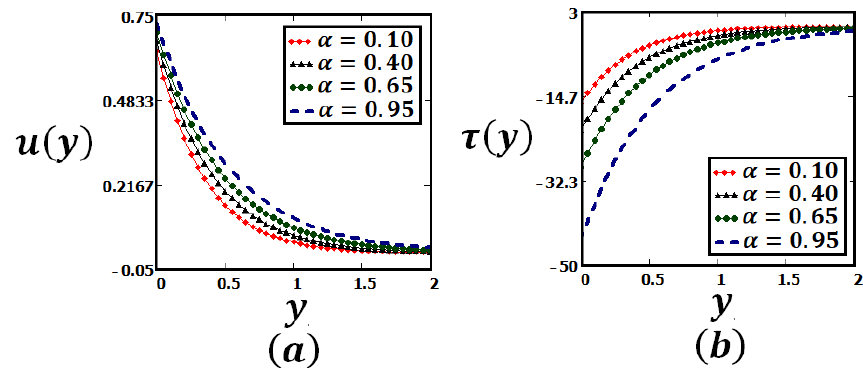
Figure 8: Profiles of the velocity field u ( y , t ) and the shear stress τ ( y , t ) for fractionalized Jeffrey fluid given by Eqs. (16) and (21), for A =